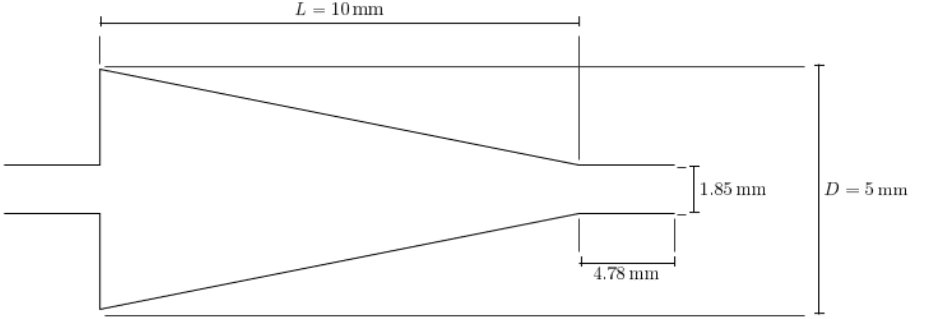
Figure 9. Detailed geometry and dimensions of the nozzle connector used. The same nozzle was used in both converging and diverging configurations.